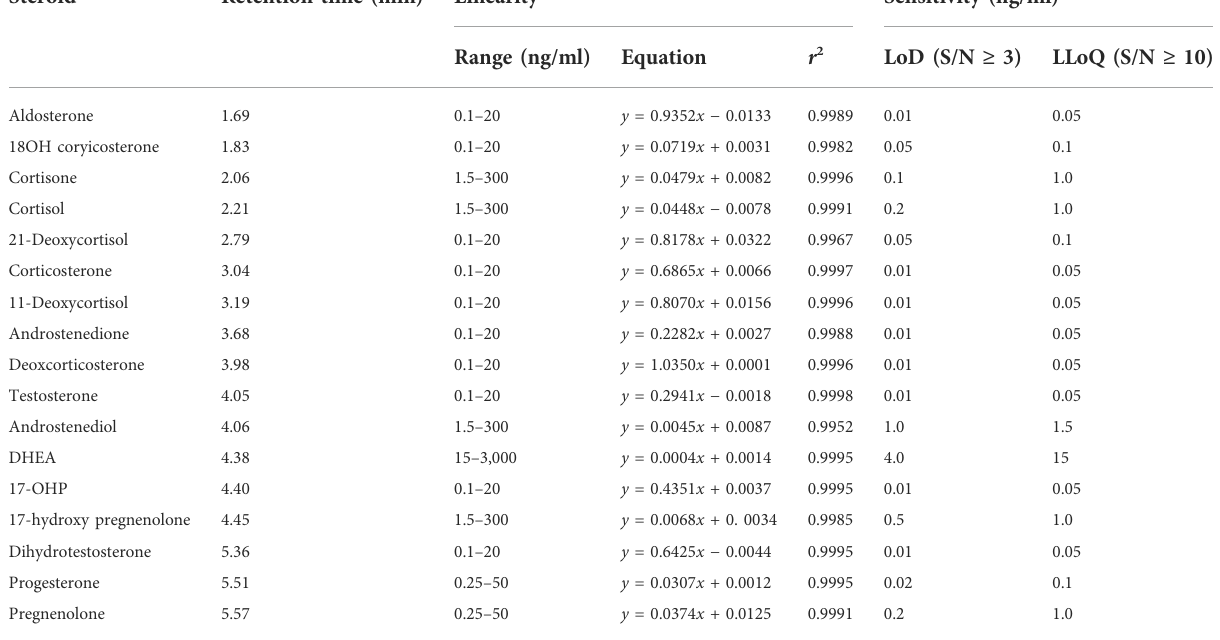
TABLE 2 Retention time, linearity, and sensitivity for each